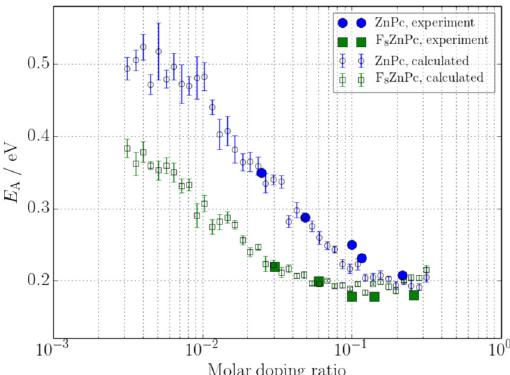
Fig. 4 Calculated and experimental activation energy of conductivity for ZnPc and F 8 ZnPc. The main difference in molecular parameters between ZnPc and F 8 ZnPc is their CT-binding energy with the dopant E C (see Supplementary Table 2 for parameter values). Strikingly, the difference in E C is enough to accurately explain the difference in pronounced at low-doping ratios. The reason is the deeper lying Fermi level for ZnPc due to the low E C . Error bars show one standard deviation. Experimental data reproduced from ref. 40